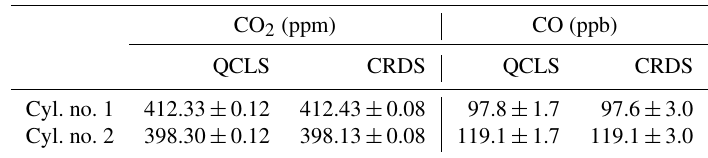
Table 1. CO 2 and CO calibration values together with 1 σ uncertainties of the calibration curves as obtained with the QCLS and a cavity ring-down spectrometer (CRDS) for comparison of calibration results. COS calibration values could not be compared with that from other instrumentation.